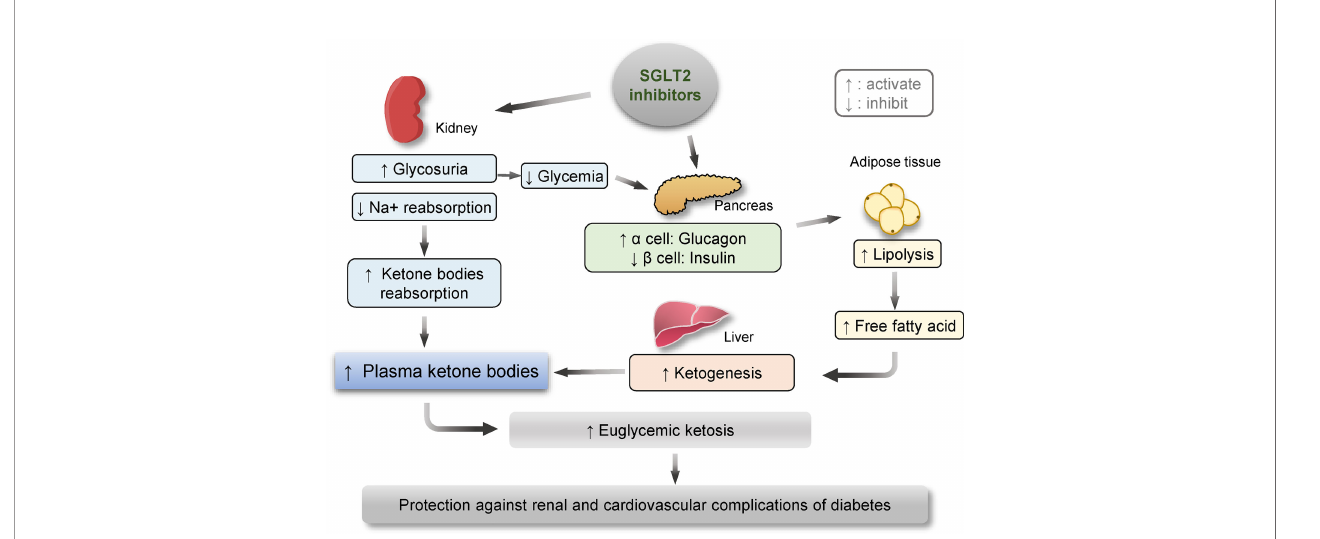
FIGURE 2 | Schematic diagram depicting the metabolic reprogramming subsequent to therapeutic targeting of SGLT2, including enhanced ketogenesis, lipolysis and glucagon effects. One of the major actions of SGLT2 inhibitors is to block SGLT2 in renal proximal tubular epithelial cells and thus reduce renal reabsorption of sodium and glucose, leading to glycosuria and normalized glycemic levels in patients with diabetes. The glycosuric effect of SGLT2 inhibitors is associated with increased renal reabsorption of ketone bodies, contributing to an elevated plasma level of ketone bodies. On the other hand, SGLT2 inhibitors-reduced glycemic levels may augment the pancreatic release of glucagon and decrease insulin production, which together act on fat tissue and promote lipolysis. Ampli fi ed levels of free fatty acid in blood along with reduced glycemic levels may reinforce ketogenesis in the liver, ultimately resulting in ketosis, which has been lately demonstrated to confer a protective effect on the kidney and the cardiovascular system in both diabetic and non-diabetic kidney